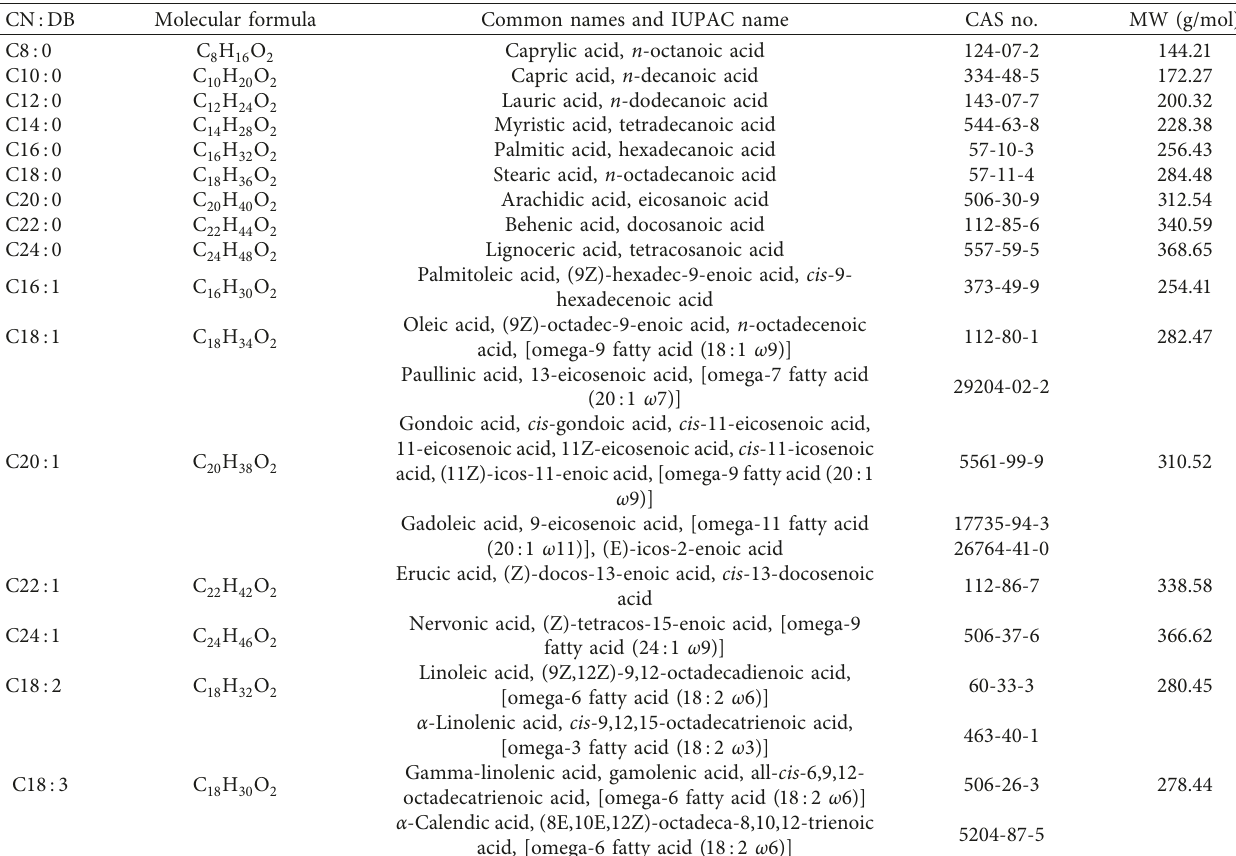
H O (b); C18: 2, linoleic acid C 18 34 2